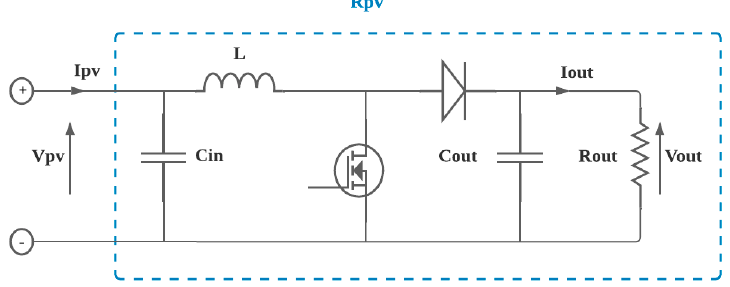
Figure 11. Schematic of the MPPT boost